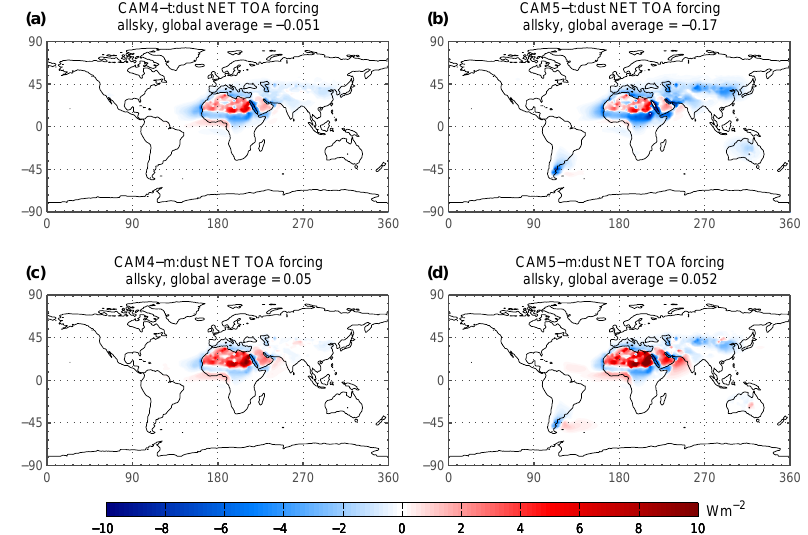
Figure 14. Spatial distribution of annual all-sky radiative forcing (SW + LW) at the top of atmosphere for CAM4 with tuned dust and with mineralogy (a, c) and for CAM5 with tuned dust and mineralogy (b, d) .